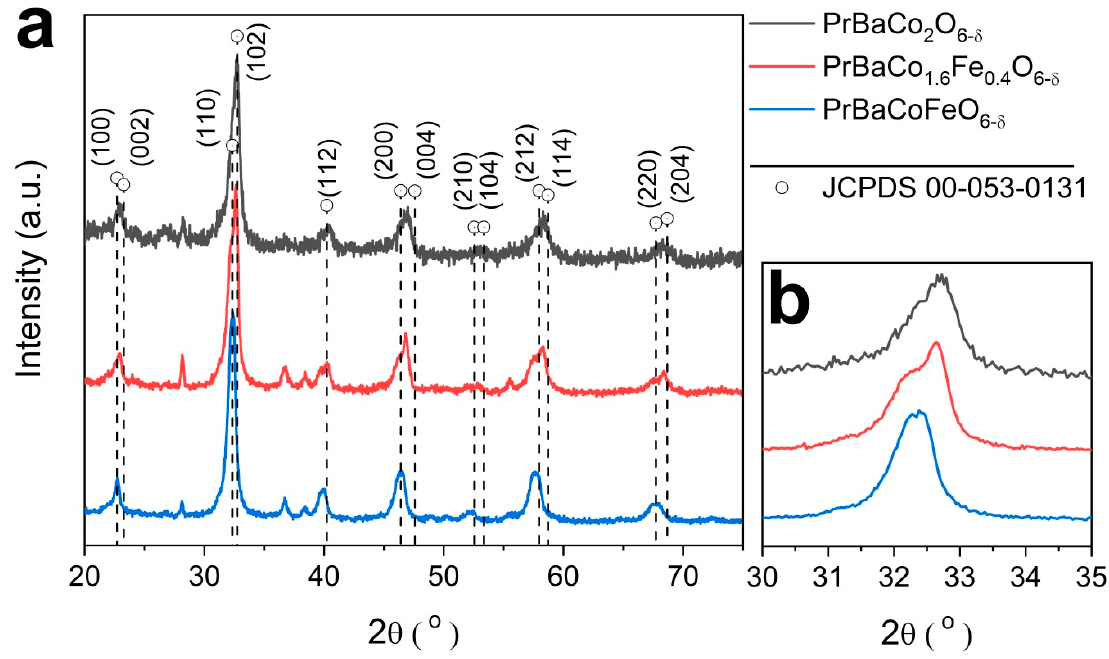
Figure 2. ( a ) comparison of X-ray diffraction (XRD) patterns of PBC (black), PBCF82 (red), and PBCF55 (blue). The XRD patterns are well indexed to those of PrBaCo 2 O 6- δ from literature (JCPDS 00-053-0131); ( b ) magnified view of the main XRD peak.